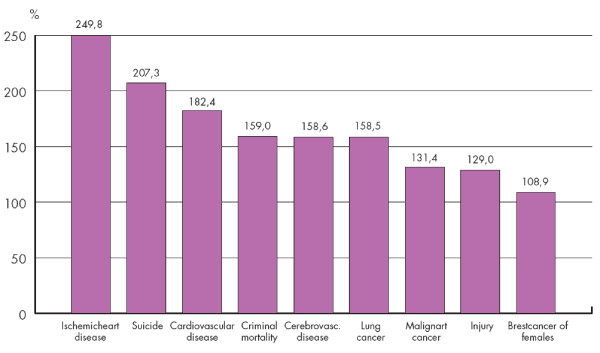
Ratio of the mortality rate by main cause of death in Hungary compared to EU-25 countries1